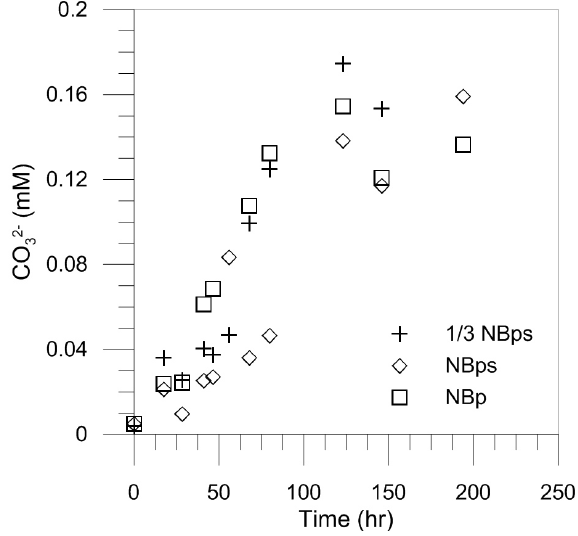
Fig. 2. Calculated changes over time in CO 2 − treatments NBp ( (cid:3) ), NBps ( ♦ ) and 1 / 3 NBps ( + ).